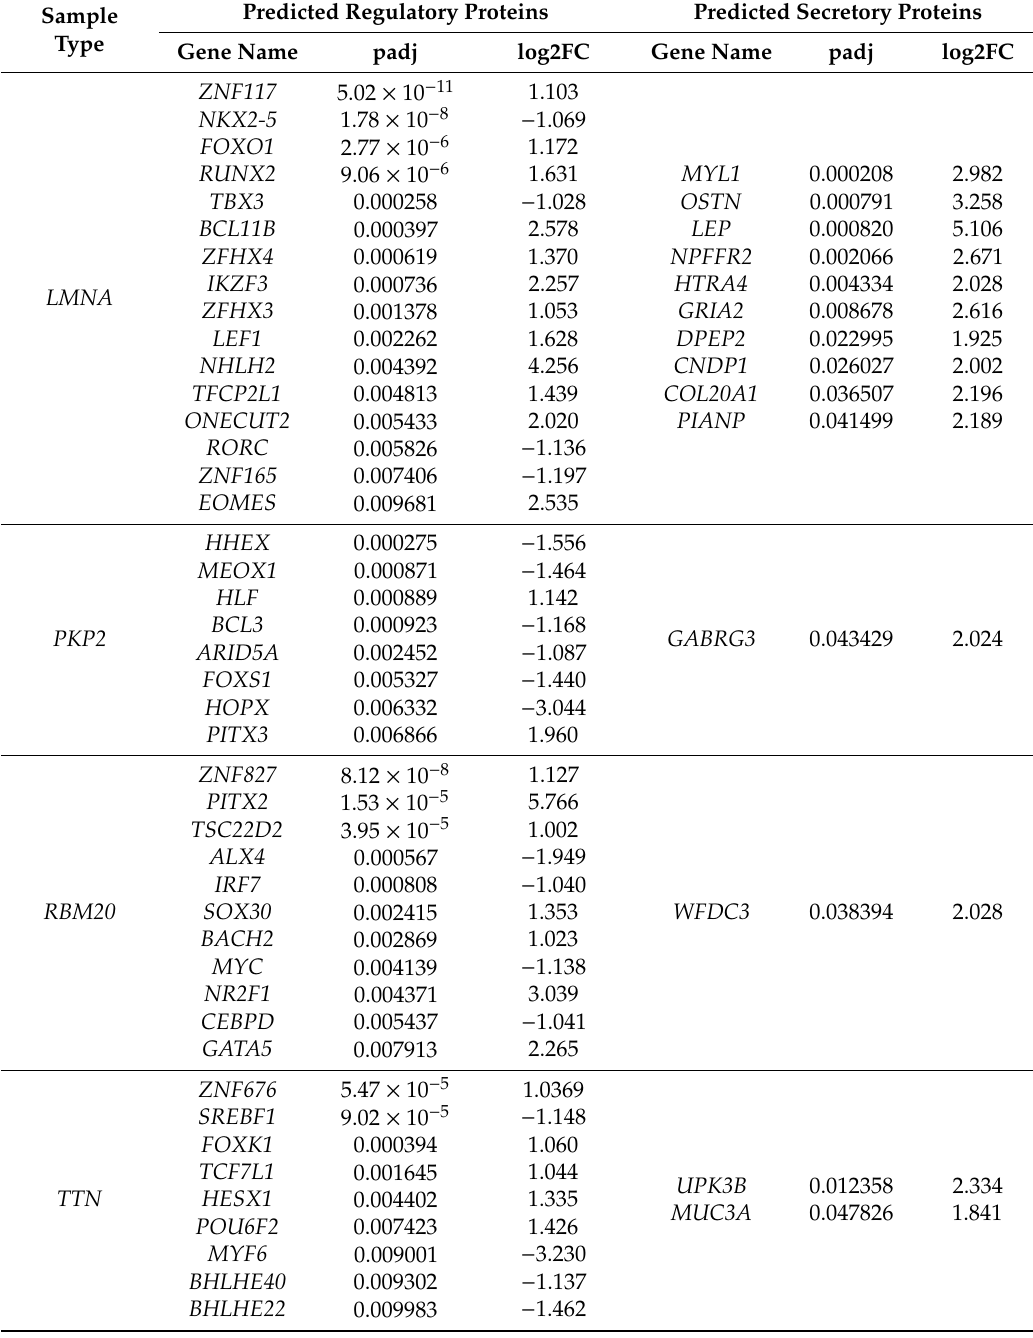
Table2. Predictedregulatoryandsecretedproteins. Genotype-specificDEGswereusedforidentification of regulatory proteins (padj < 0.01, | log2FC | > 1) and predicted secreted proteins (padj < 0.05). Lists of transcription factors and predicted secreted proteins were obtained from the human protein atlas. Potential regulatory proteins are shown on the left and secreted proteins on the